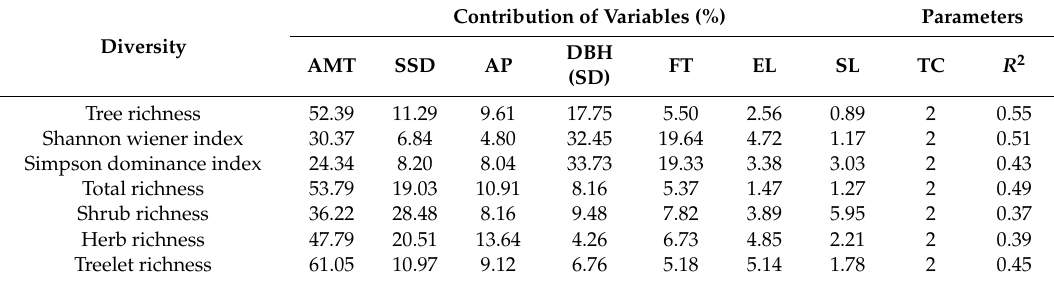
Table 2. Average contribution of variables to plant richness fitted in the three gradient boosting models (GBMs) with varying tree complexity (1, 2, and 5).